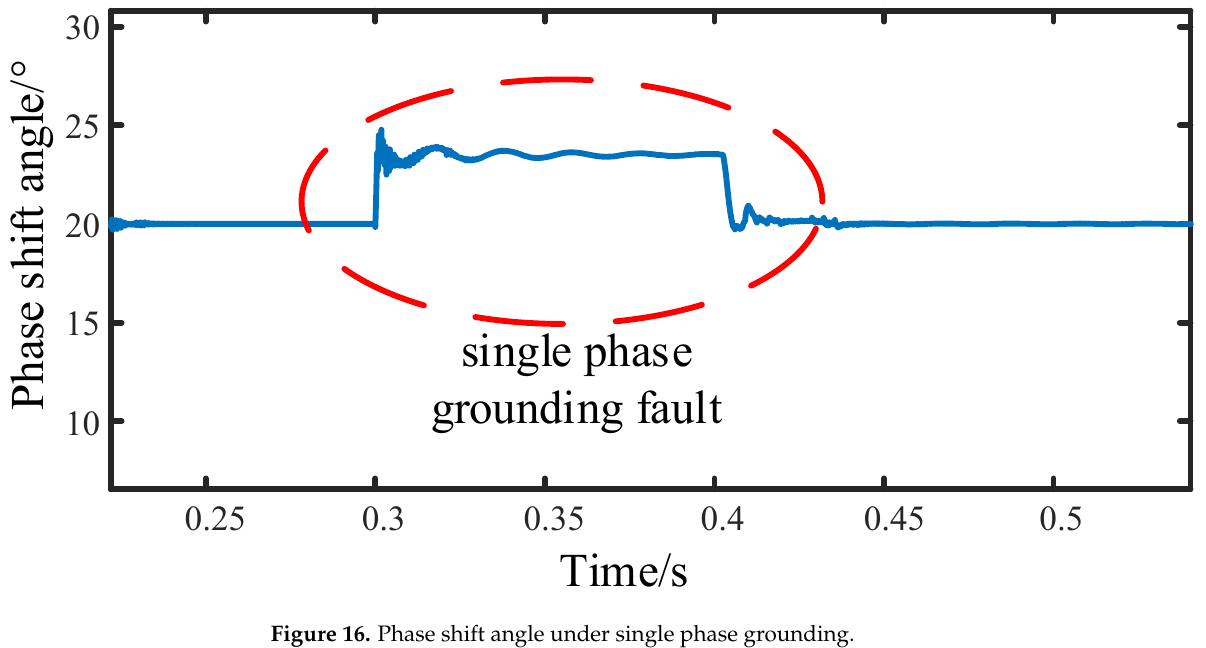
Figure 16. Phase shift angle under single phase grounding.